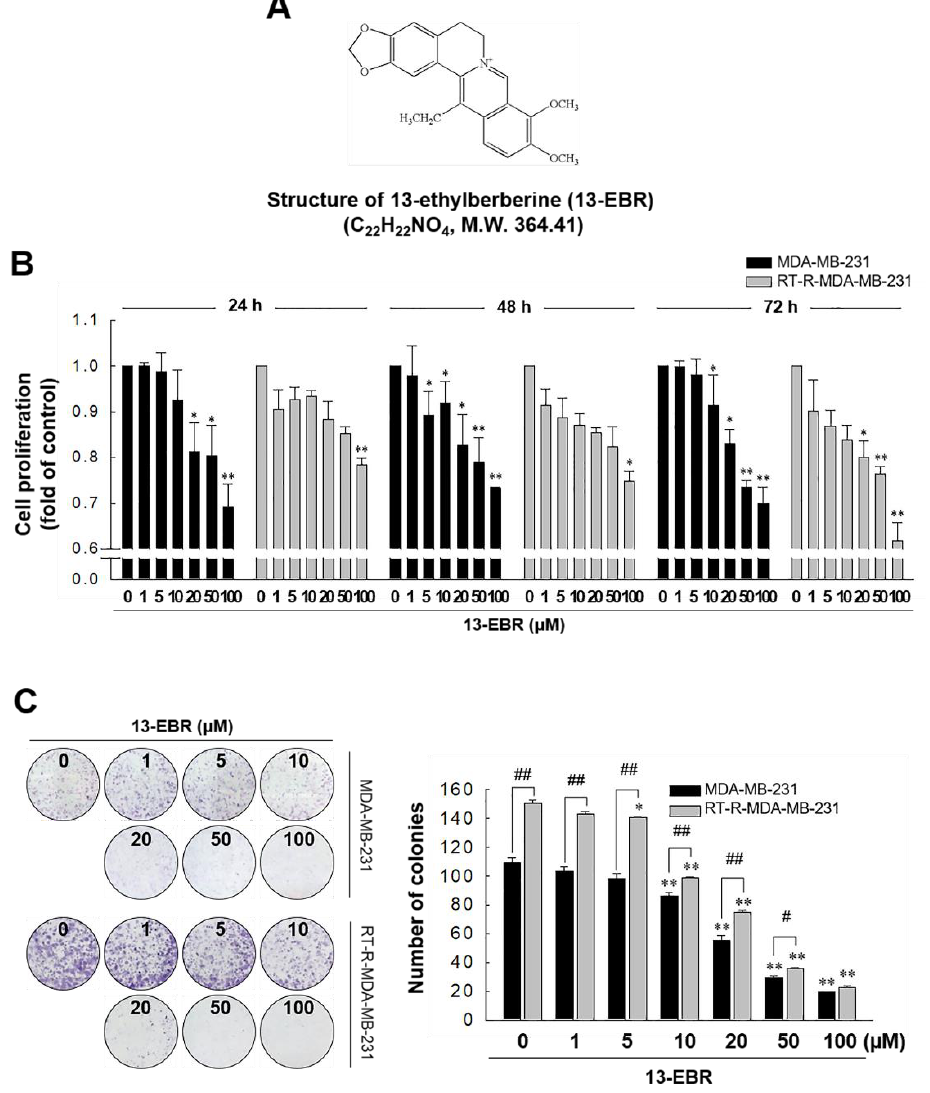
Figure 1. Chemical structure of 13-ethylberberine (13-EBR), and the effects of 13-EBR on cell proliferation, colony formation, and apoptosis in breast cancer cells. ( A ) The chemical structure of 13-EBR. ( B ) MDA-MB 231 and radiotherapy-resistant (RT-R) MDA-MB 231 cells were treated with 13-EBR at the indicated doses (1, 5, 10, 20, 50, and 100 µ M) for 24–72 h, and cell proliferation was measured using the Cell Counting Kit-8 (CCK-8) reagent, as described in Section 4. The values represent the mean ± standard error of the mean (SEM) of three independent experiments; ** p < 0.01, * p < 0.05 compared to the controls (vehicle-treated cells) at each time point. ( C ) Both breast cancer cell lines (1000 cells / well) were seeded in six-well plates. The cells were stimulated with 13-EBR for 24 h at the indicated doses. Following treatment, a colony-formation assay was performed, as described in Section 4, and was quantified by counting the colonies. The values represent the mean ± SEM of three independent experiments; ** p < 0.01, * p < 0.05 compared to the control for each cell line; ## p < 0.01, # p < 0.05 compared to the MDA-MB-231 cells.